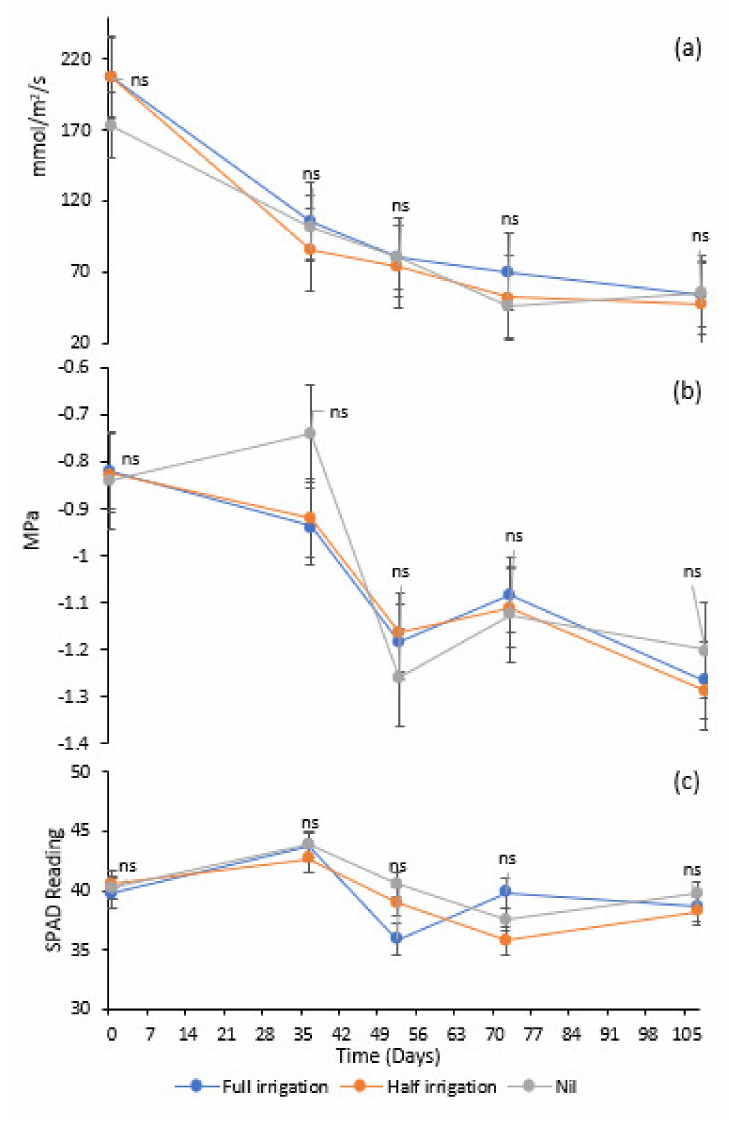
Figure 5. Vine leaf physiological measurements for 107–day test period in commercial Cypriot Xynisteri vineyard 2019. ( a ) stomatal conductance (mmol/m 2 /s), ( b ) stem water potential (MPa), ( c ) SPAD reading-indicative chlorophyll content. Full irrigation–44 L/vine, Half irrigation–22 L/vine, Nil-no irrigation. Each data point is a mean of n = 12 vines. Bars indicate the standard error. Means were separated by ANOVA using Tukey’s test, ns—not statistically